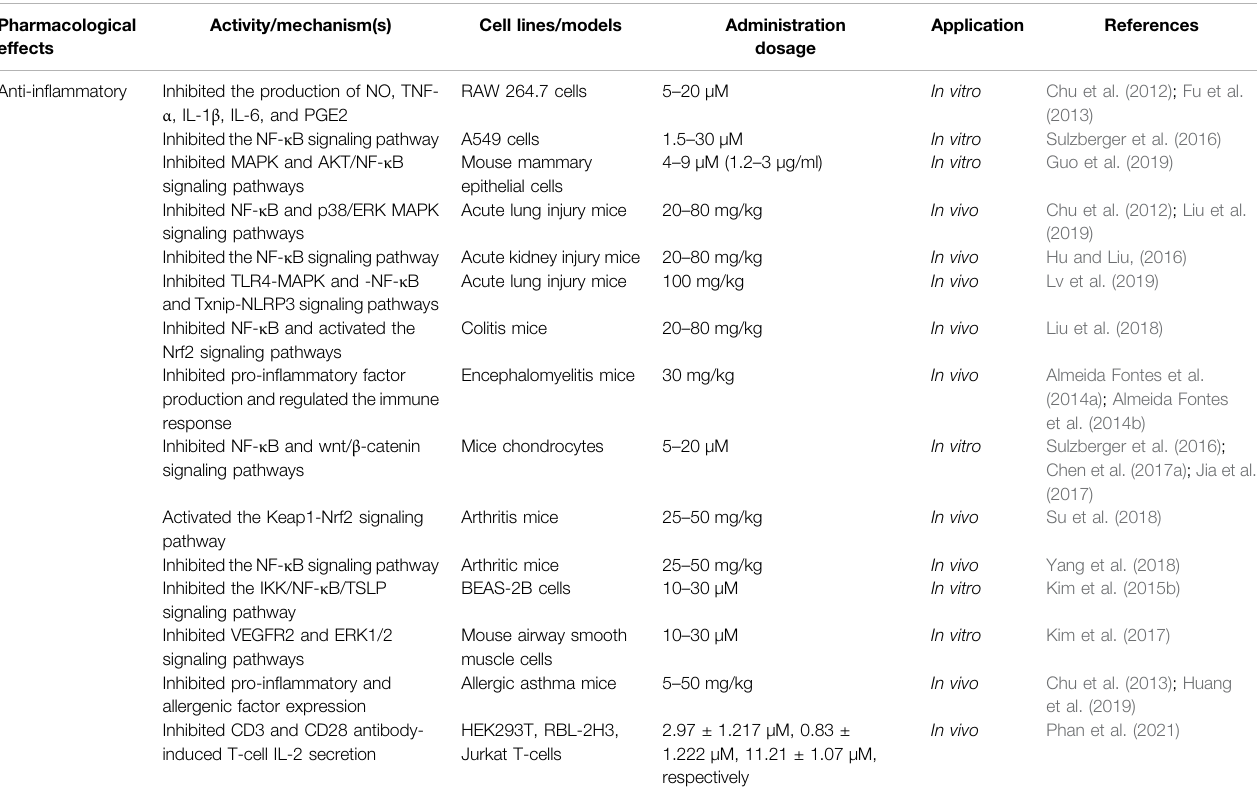
TABLE 2 | Anti-in fl ammation activities of